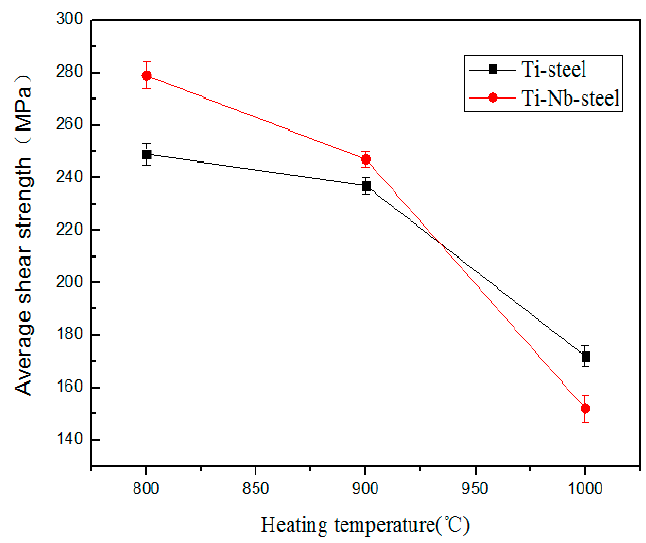
Figure 12. The shear properties of the Ti/Nb/steel and Ti/steel interfaces at different heating temperatures.